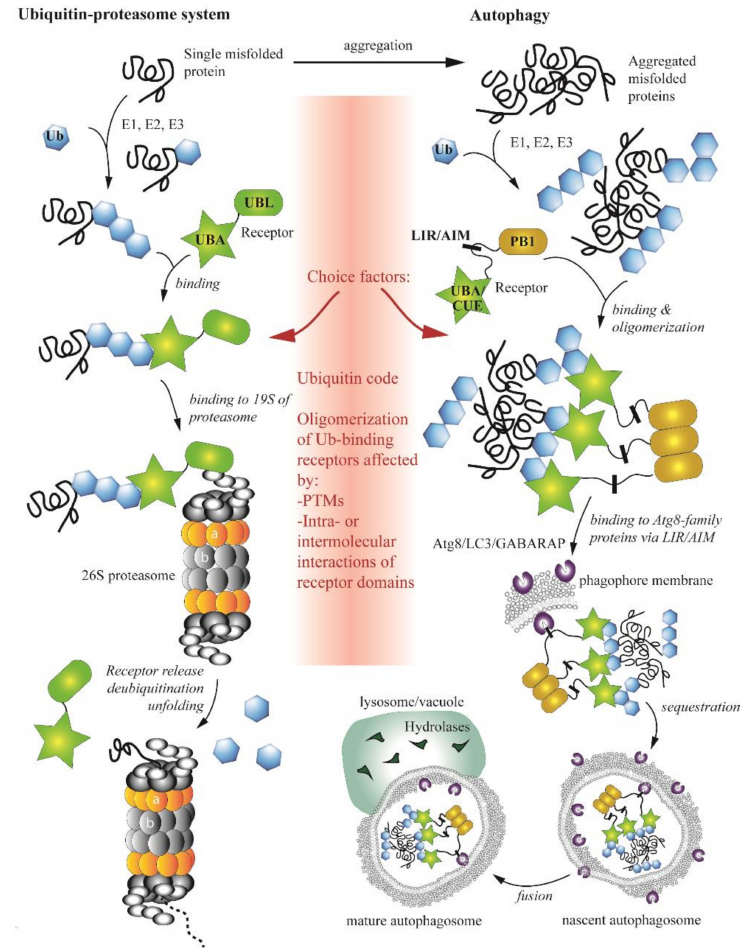
Figure3. DegradationofmisfoldedproteinsbytheUPSandautophagy. Misfoldedproteinsaremodified by the ubiquitination machinery involving the E1-E2-E3 enzymatic cascade. In the UPS ( left ), a mono- or poly-ubiquitin moiety on a single misfolded protein is recognized by a ubiquitin-associated (UBA) domain of a ubiquitin-binding receptor acting in the UPS, for example, Dsk2 in yeast. This complex is targeted to the 26S proteasome, where 19S subunits recognize a ubiquitin-like (UBL) domain of a receptor. After receptor release, deubiquitination, and unfolding of a misfolded protein, the 20S core cylinder composed of α and β subunits loads the protein for degradation. In autophagy ( right ), ubiquitin chains of misfolded protein aggregates are recognized by UBA domains of receptors acting in autophagy, for example, Cue5 in yeast. Oligomerization of these receptors via their UBA and Phox and Bem1 (PB1) domains is essential in high-a ffi nity binding of receptors to ubiquitin. At the same time, the LIR / AIM motif of each receptor must be accessible for binding to Atg8-family proteins, and, thereby, targeting the receptor-substrate complex to the autophagy machinery. Specifically, the LIR / AIM motif binds to two hydrophobic pockets on the surface of Atg8 / LC3 / GABARAP that decorate the phagophore membrane. Expansion of the phagophore ultimately leads to sequestration of the cargo (that is, substrates with their corresponding receptors) by the nascent autophagosome that is decorated on the inner and outer membrane by Atg8-family proteins. After release of various proteins from the outer membrane, the mature autophagosome fuses with a degradative organelle, the vacuole in yeast and plants, and lysosomes in more complex eukaryotes, where hydrolases break down the cargo. The major factors ( red ) a ff ecting which pathway will be used for misfolded-protein degradation are the ubiquitin code and ubiquitin-binding receptors. Binding a ffi nity of each receptor to ubiquitin is determined by its oligomerization status that is a ff ected by post-translational modifications (PTMs) and / or interactions between UBA, and UBL and PB1 domains of